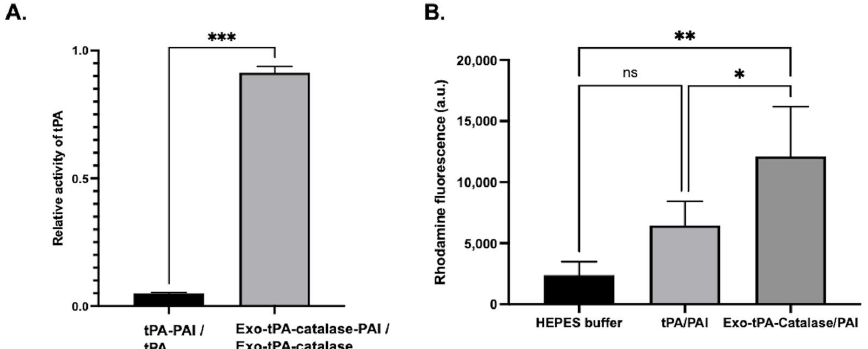
Figure 5. Activity and clot lysis assay of the exo-tPA-catalase formulation. ( A ) Activity of tPA and exo-tPA-catalase with and without plasminogen activator at equimolar amount. ( B ) Clot lysis due to tPA, exo-tPA-catalase, and buffer treatments were measured at 24 h. The rhodamine re-lease was measured using a plate reader. n = 3 ± SEM, * p < 0.05, ** p < 0.01, *** p < 0.001.